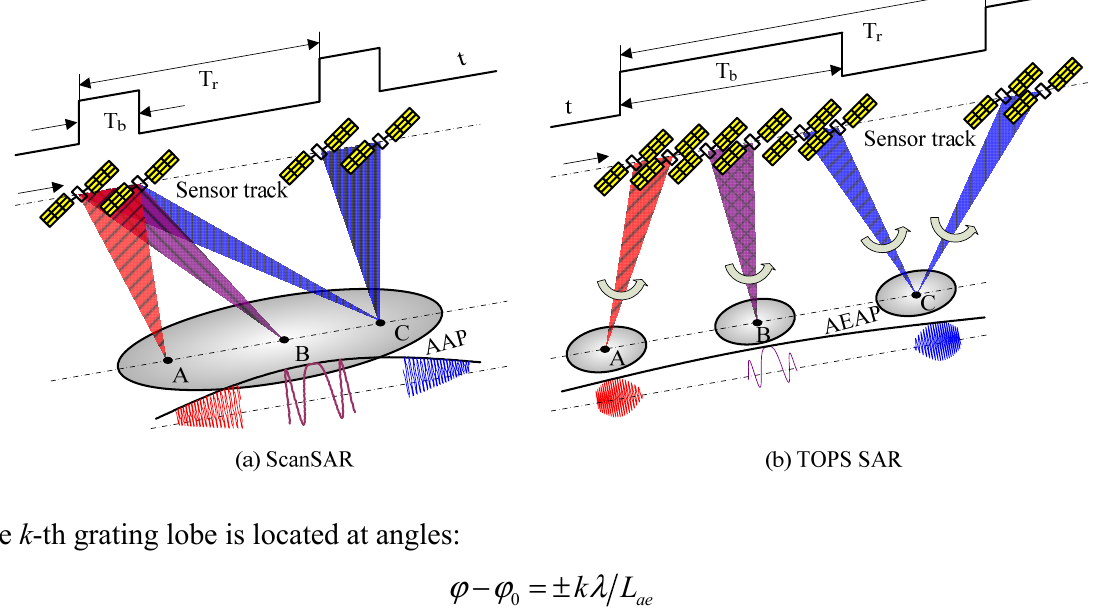
Figure 3. Different azimuth burst imaging schemes in ScanSAR and TOPS. ( a ) ScanSAR; ( b ) TOPS SAR. (SAR = synthetic aperture